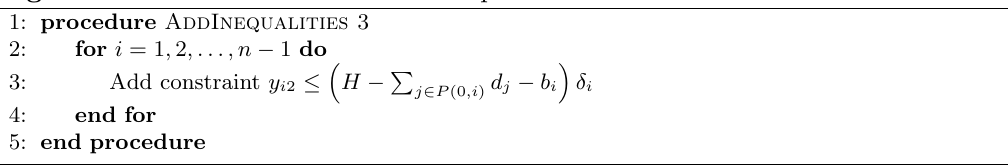
Algorithm 4 Add third set of valid inequalities to